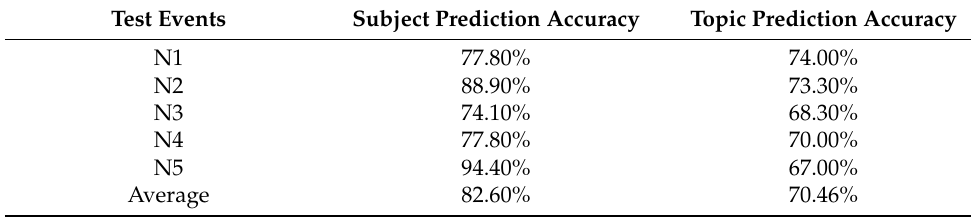
Table 11. Results Prediction Accuracy